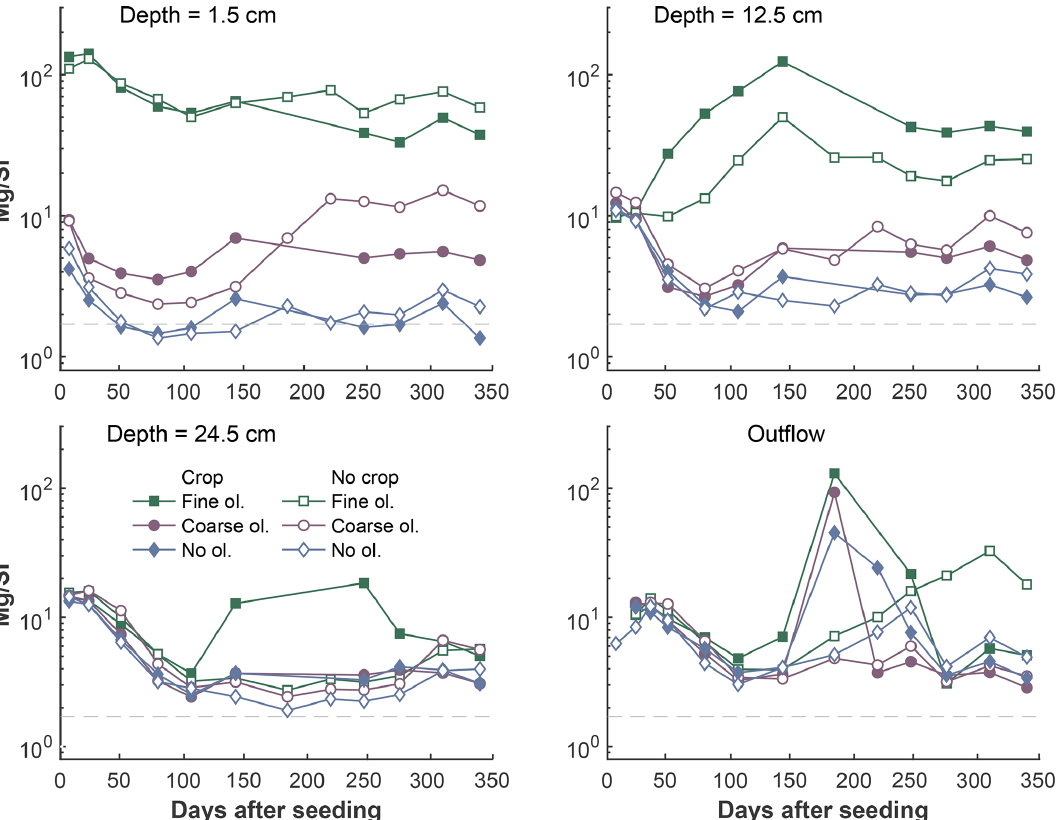
Figure 7. Development of Mg / Si ratios over the experiment period in the surface layer, differentiated by olivine and crop treatment. The dashed grey line indicates the stoichiometric Mg / Si ratio of 1.8 based on the rock chemistry. Data points are averages but error indicators were omitted to provide a better overview. For a more differentiated view and standard deviations, please refer to Fig. S7-1.